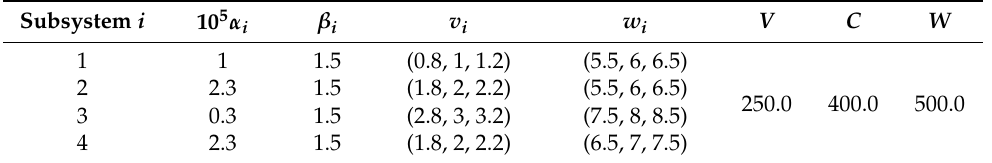
Table 3. Data for benchmark 4